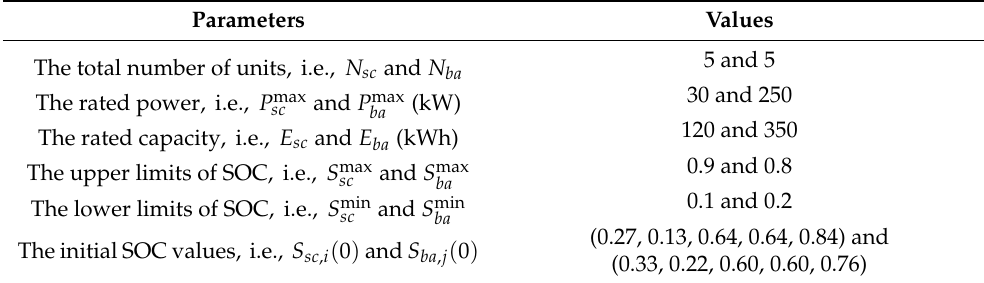
Table 1. Parameters of hybrid energy storage devices. Parameters